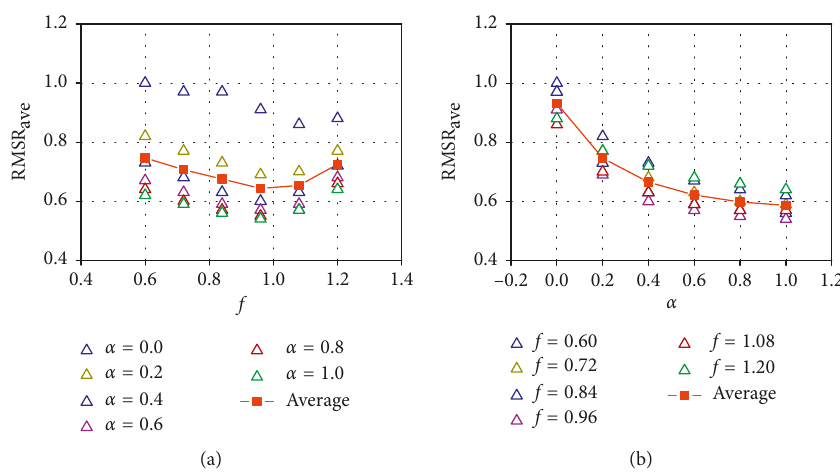
Figure 9: (a) Relationship between RMSR